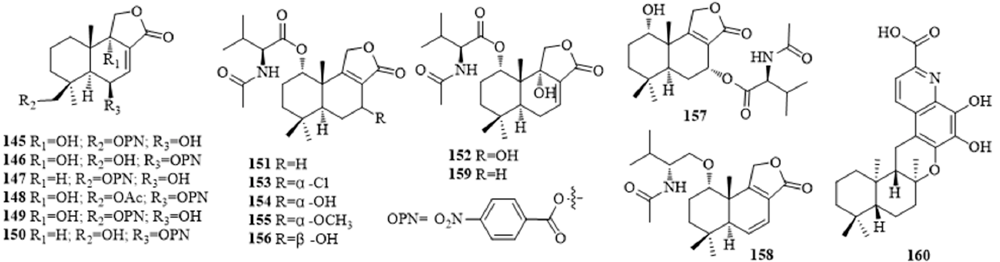
Figure 2. The structures of compounds 145 – 160.